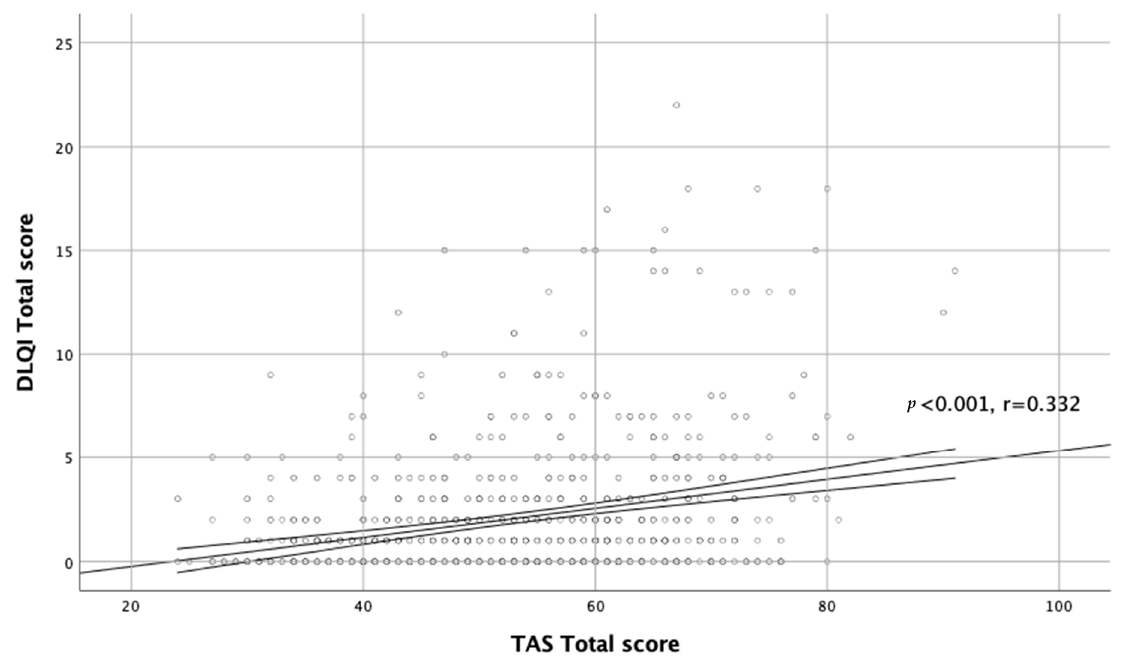
Figure 2. Correlation between TAS total score and DLQI total score. After analyzing the domains of alexithymia we documented the significant correla- tions between DIF and DLQI (r = 0.316, p < 0.001) and between DDF and QoL (r = 0.207, p < 0.001). EOT did not correlate with QoL impairment in our cohort of acne subjects. The same relationships were noted in both sex groups with acne (Table 3). Table 3. Correlations between alexithymia and quality of life impairment as well as stigmatization in pupils with acne.